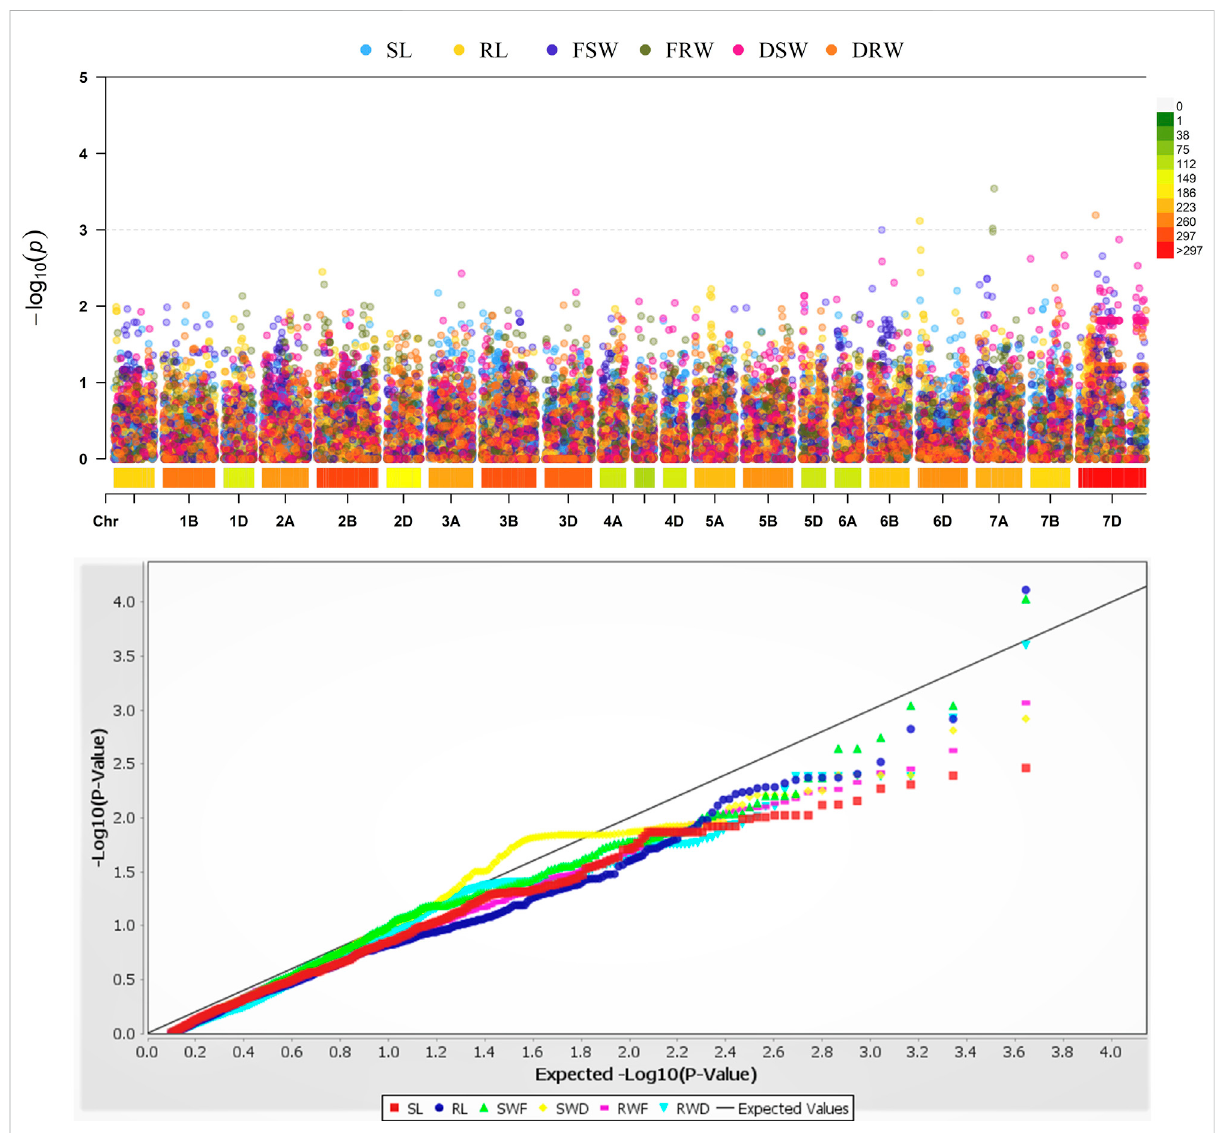
FIGURE 4 Genome-wide association analysis of seedling-related trait loci in the A, B, and D genomes of wheat. SL: shoot length; RL: root length; FSW: fresh shoot weight; FRW: fresh root weight; DSW: dry shoot weight; DRW: dry root weight.